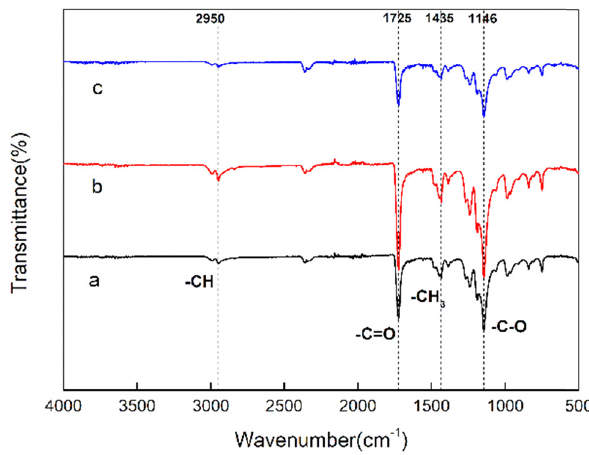
Figure A1: FTIR spectra of NIM ( a ) , MIM before elution ( b ) , and MIM after elution ( c ) .